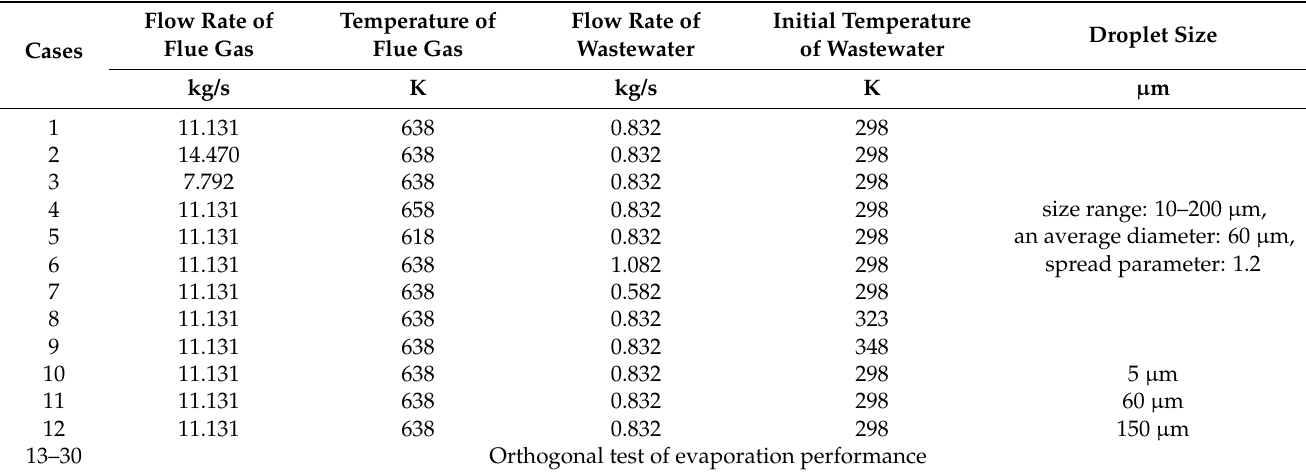
Table 2. Case setting.